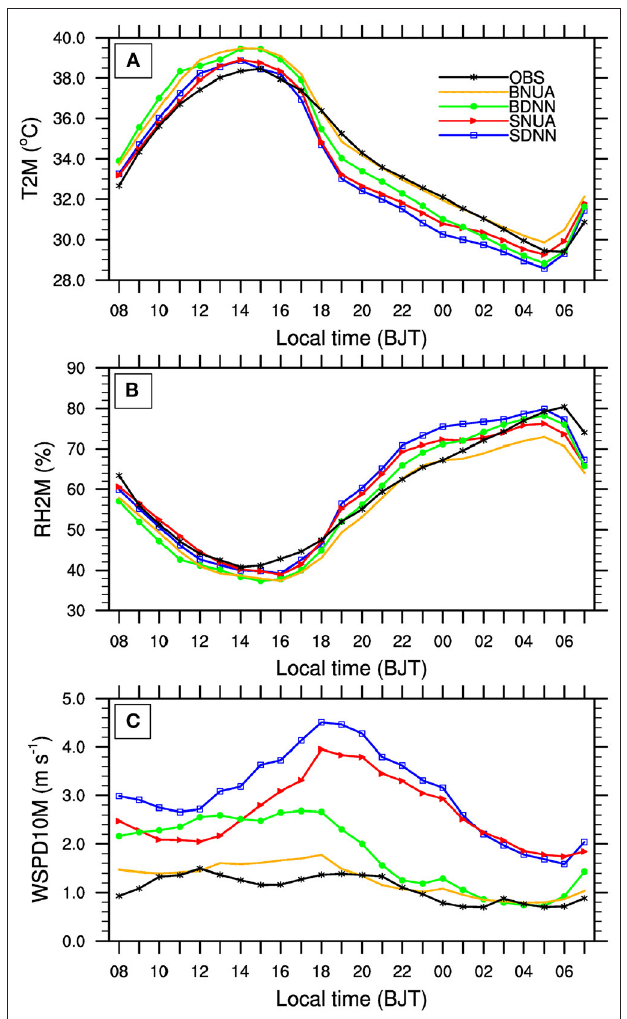
FIGURE 8 | The diurnal variation of (A) temperature at 2m, (B) relative humidity at 2m, (C) wind speed at 10m from 0000 UTC July 22, 2016 to 0000 UTC July 25, 2016 in downtown Hangzhou.